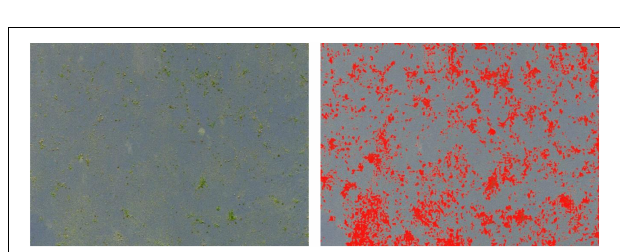
FIGURE 4 | One of 26 settlement panels exposed to the submarine spring (left: settled areas in green, yellowish; right: identical areas in red to quantify the proportion of settlement in percent by using